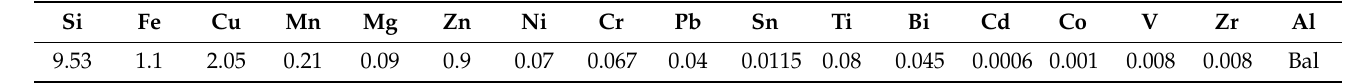
Table 1. Alloy composition in wt.